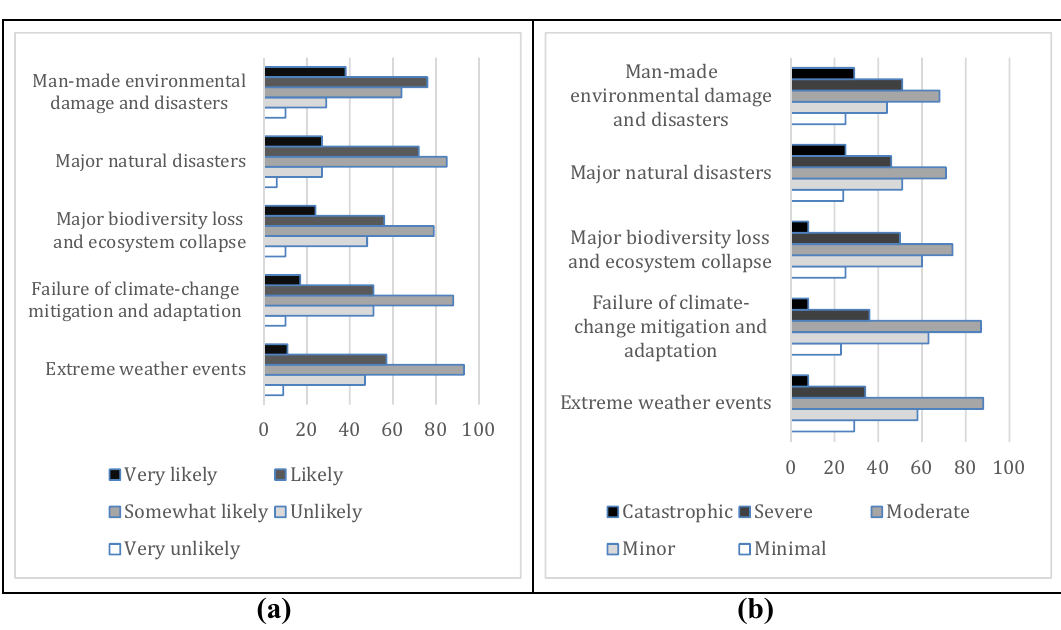
Fig. 2 Stated likelihoods ( a ) and consequences ( b ) of the global environmental risks by the surveyed small and medium enterprises in Turkey